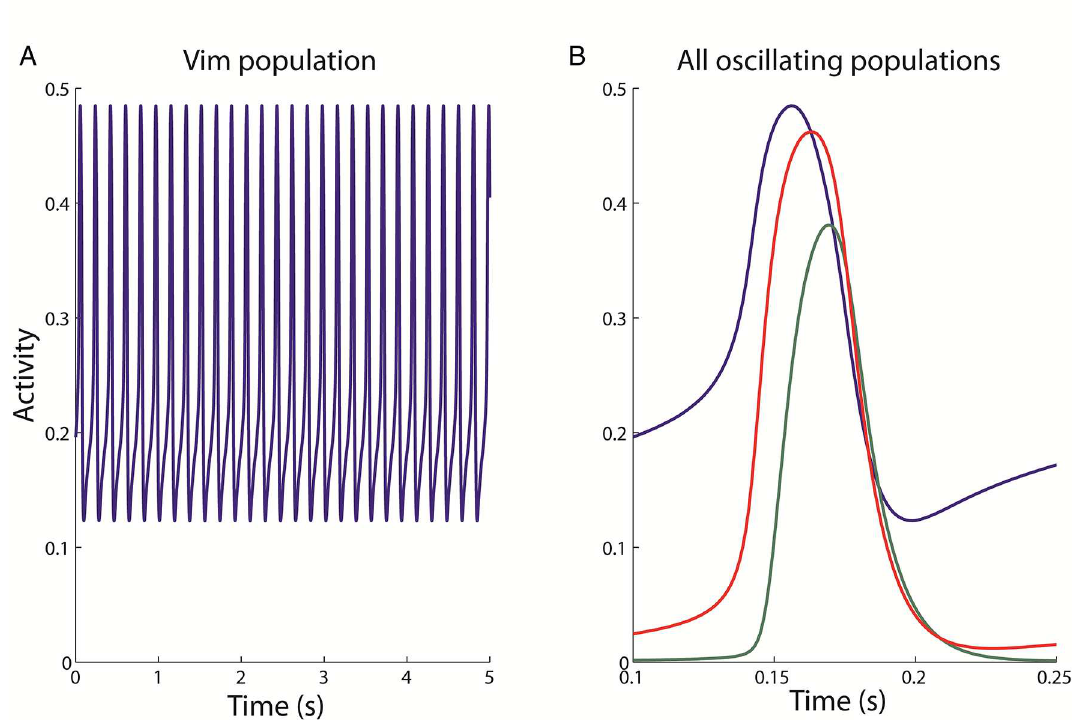
Fig 4. The oscillatory activity observed in the model. The activity of the Vim population alone (A) is shown over 5 secondsof simulatedtime, and for the three populations(B) displayingoscillations for approximately one cycle (0.25 seconds). The oscillationamplitudeis stable over time for any one population,but varies across populations.The oscillation is lead by the Vim population(blue), then followedby the nRT (red) and finally the cortex